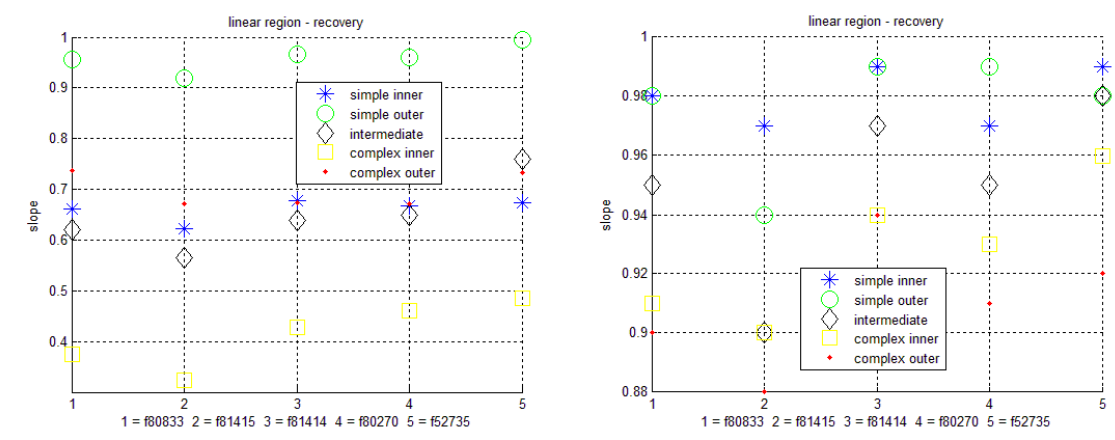
Figure 19. Linearity, recovery phase: ( left ) un-insulated case; ( right ) insulated